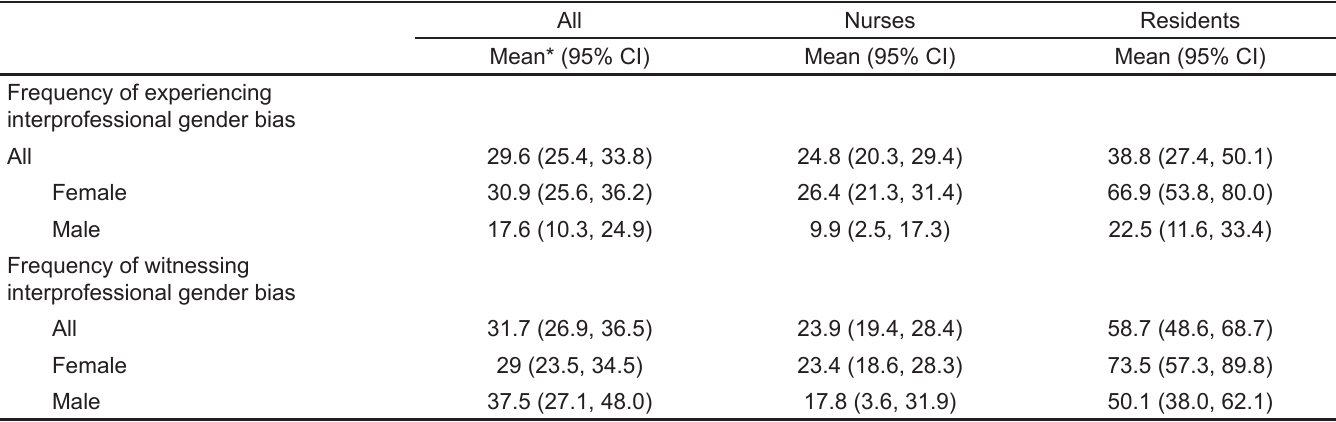
Table 3. Perceptions of gender bias in interprofessional interactions.